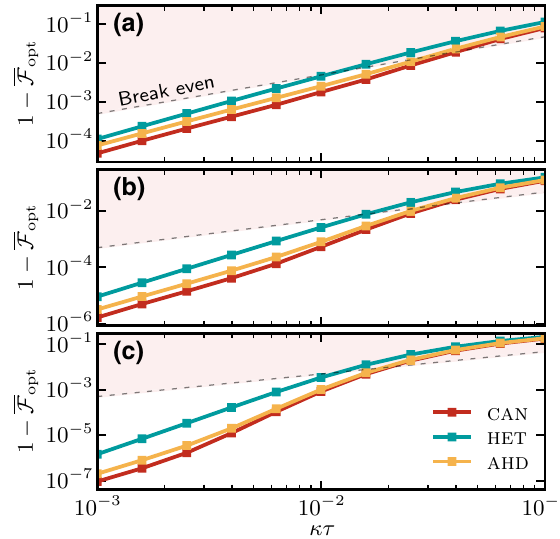
FIG. 7. Maximum average gate infidelity as a function of noise strength κτ for bin codes, and different realizations of the phase measurement. For each value of κτ , the code with the optimal average photon number n code that maximizes 1 − F is chosen. Panels (a)–(c) show the results for the order N = 2, order N = 3, and order N = 4 bin codes,